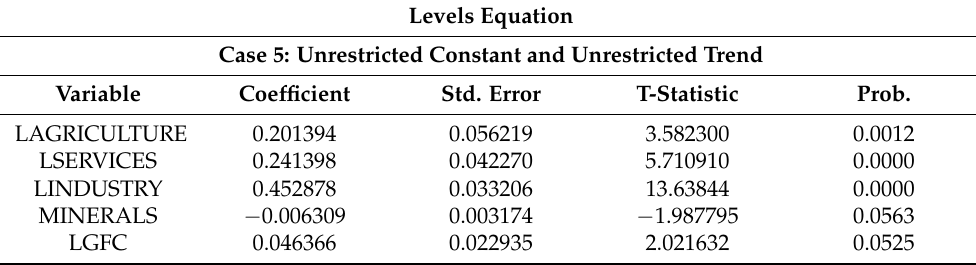
Table 6. Long-run impact of variables on